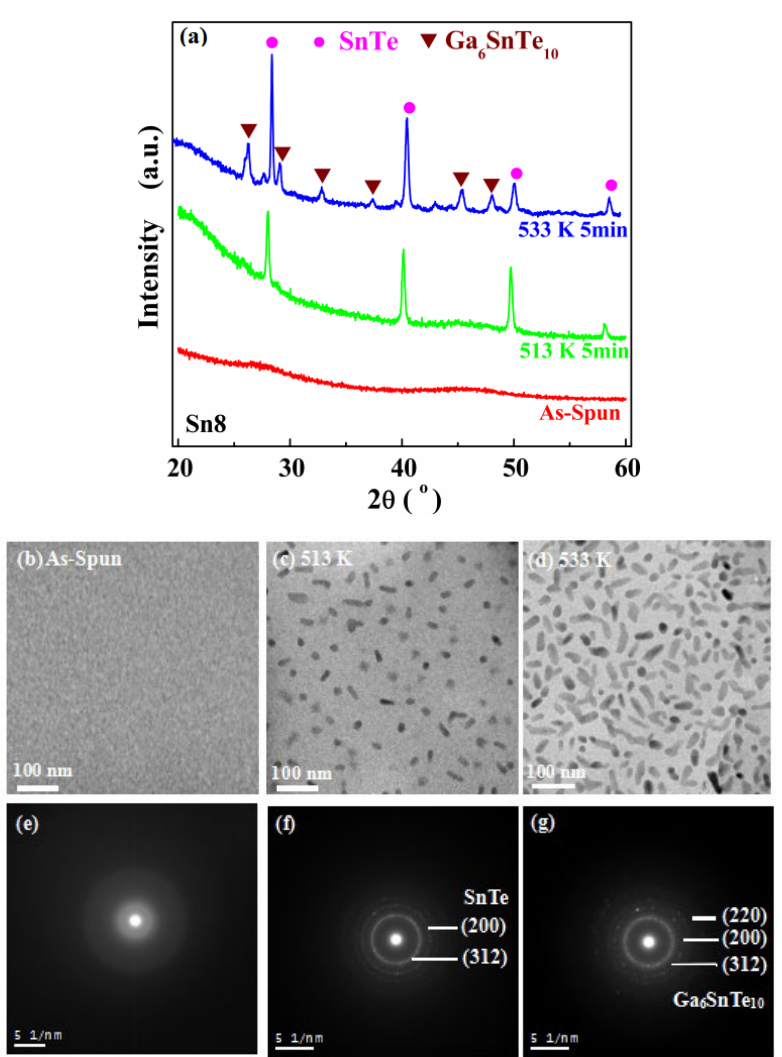
Figure 5. XRD patterns ( a ), the TEM image ( b – d ) and corresponding SAED pattern ( e – g ) of S8 amorphous sample under different annealed temperatures.